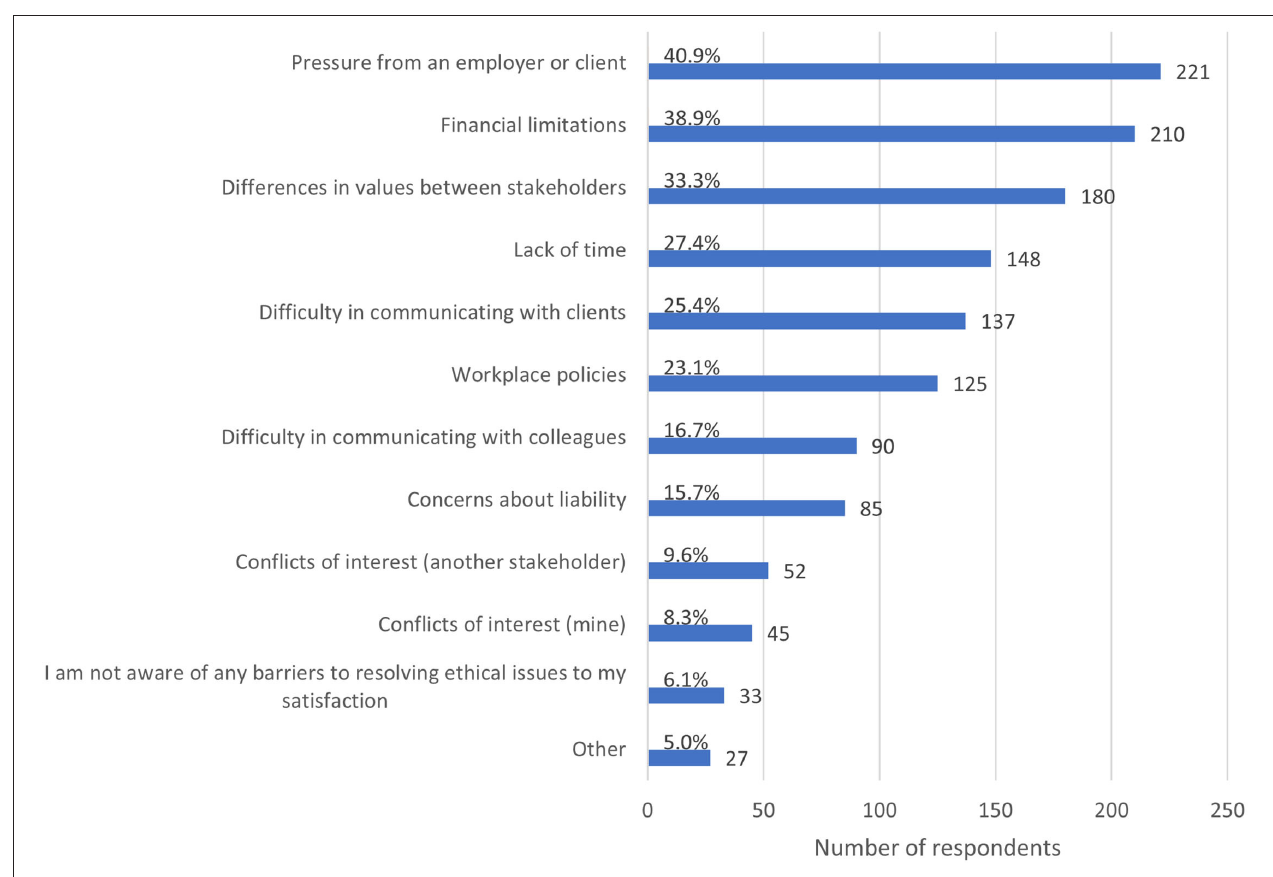
FIGURE 6 | Bar chart of barriers to resolving the most recent ethically challenging situation encountered by veterinary team members, based on the responses of 540 veterinarians, animal health technicians and veterinary nurses, surveyed between May and July in 2020. Note that respondents could select multiple